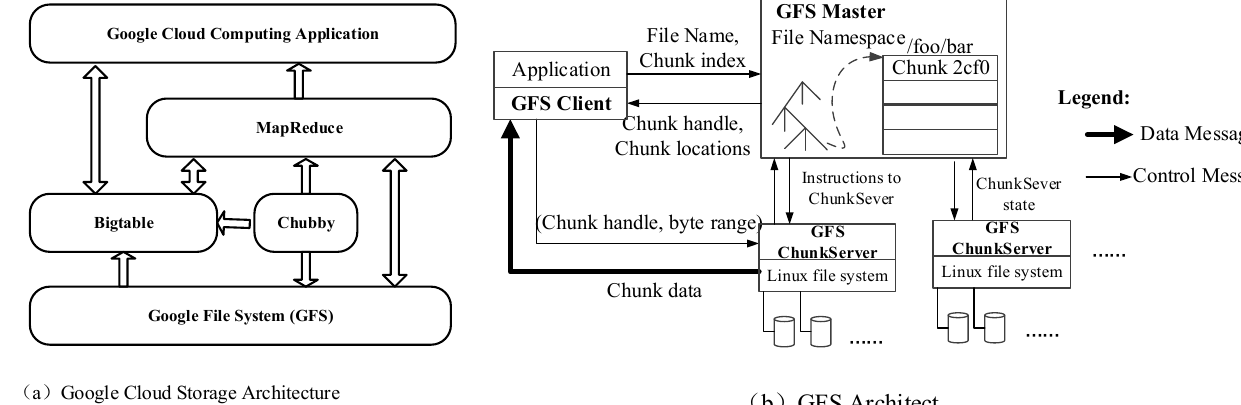
Figure 1. Google cloud storage system architecture.